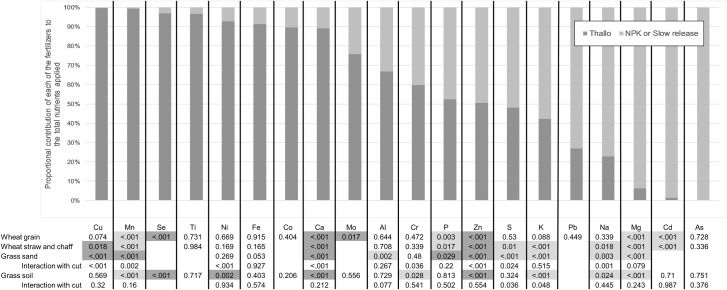
Relative additions of each element to the soil in Thallo® and mineral fertilized treatments, and statistical effects of the fertilizer type on elemental concentrations in plant material.The bars indicate the relative contribution of each of the Thallo® and mineral fertilizers (NPK or slow release) to a sum of the total quantity of each element applied to the pots. Statistically significant effects of fertilizer type on elemental composition of plants are coloured light grey to indicate that mineral fertilized plants have the greatest element concentration, or dark grey to indicate that Thallo® fertilised plant concentrations are greatest.